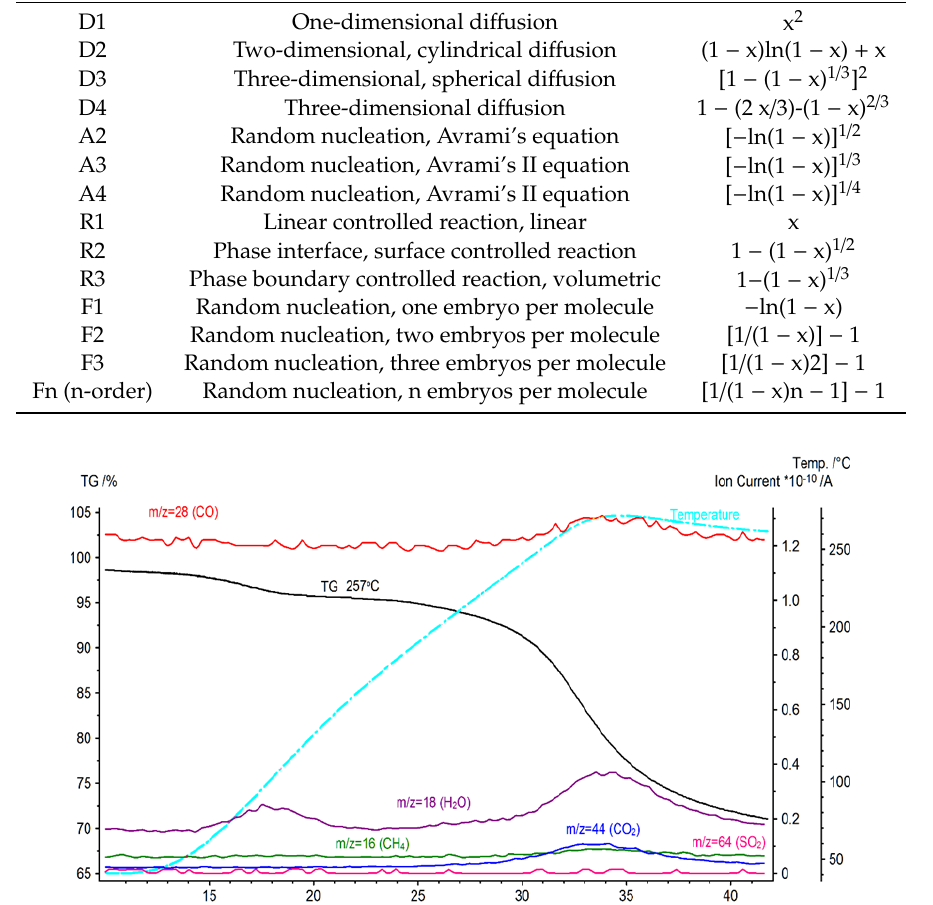
Table A3. Activation energy and pre-exponential coefficient as a function of the degree of conversion by the Ozawa–Flynn–Walla method for an oat straw sample.